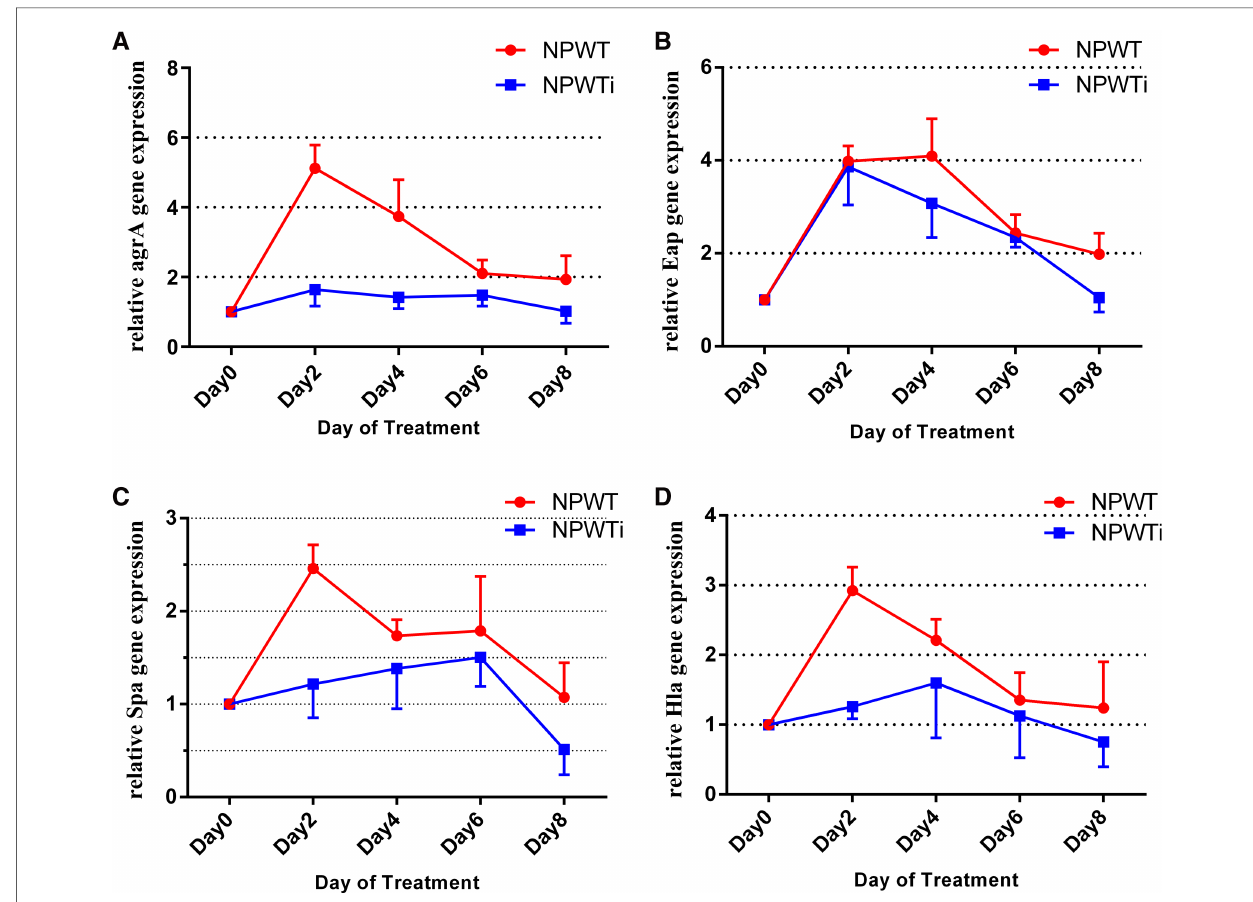
FIGURE 3 Differences in gene expression in the two treatment groups over time (fold change). ( A ) The difference of agrA expression; ( B ) The difference of Eap expression; ( C ) The difference of Spa expression; ( D ) The difference of Hla